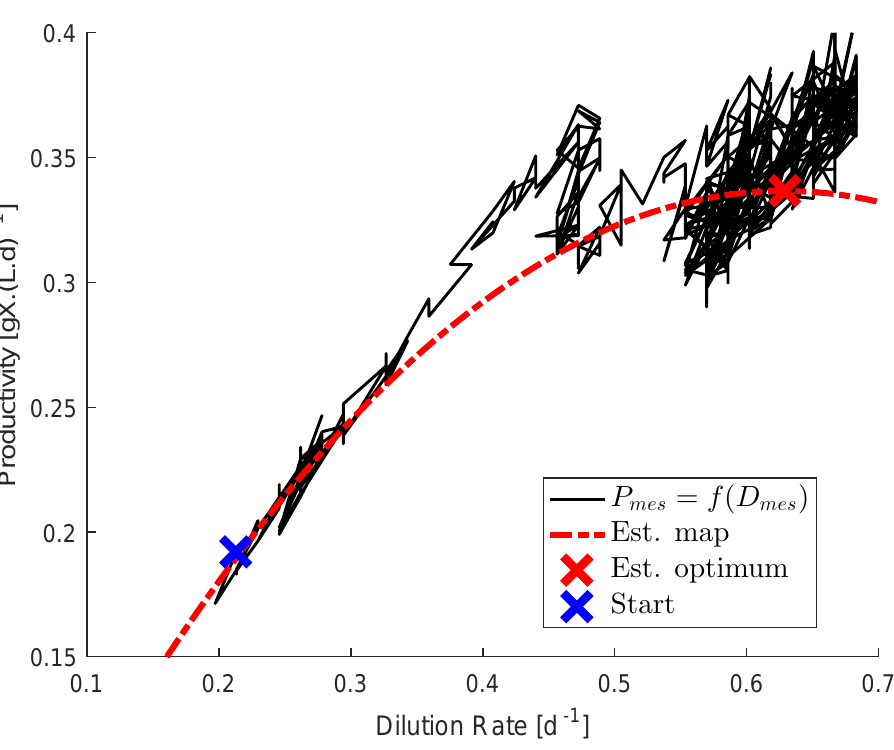
Figure 17. Experimental validation of RLS-ES on Dunaliella tertiolecta continuous cultures: productivity and dilution phase plan—reproduced with permission from [102]